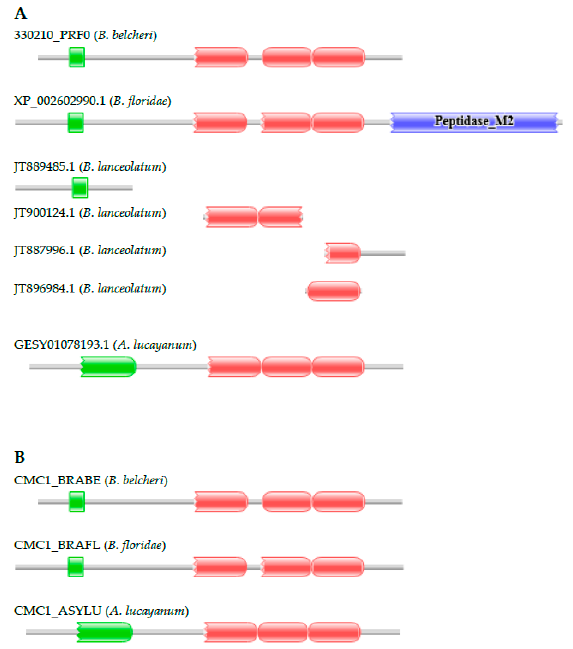
Figure 3. Genes encoding proteins with domain architectures typical of vertebrate calcium ‐ binding